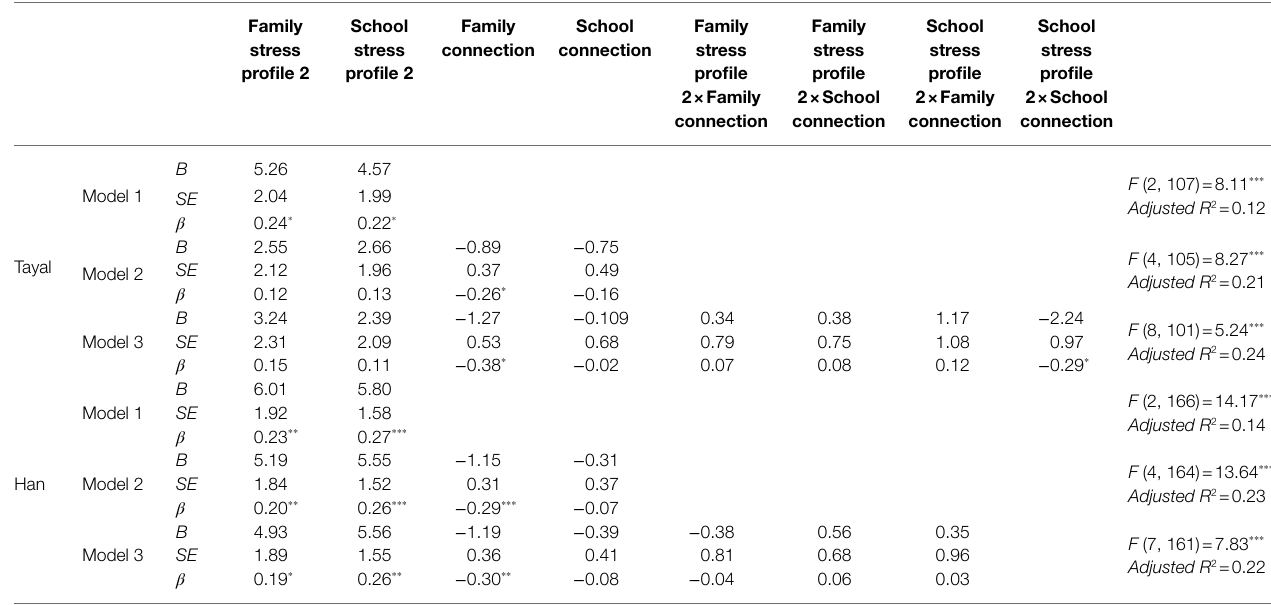
TABLE 6 | Hierarchical regression results on Tayal’s and Han’s depression using family and school stress LCA